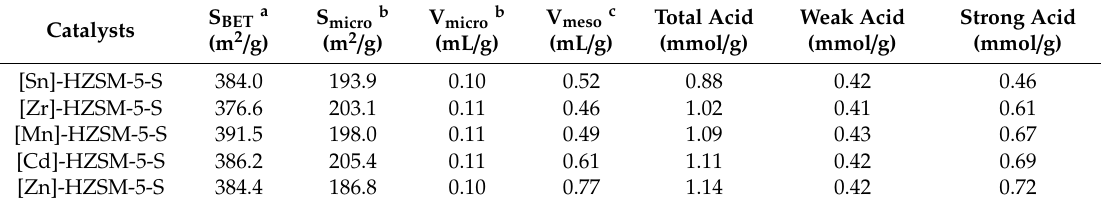
Table 4. Physical properties and acids amounts of the [M, Al]-H-S